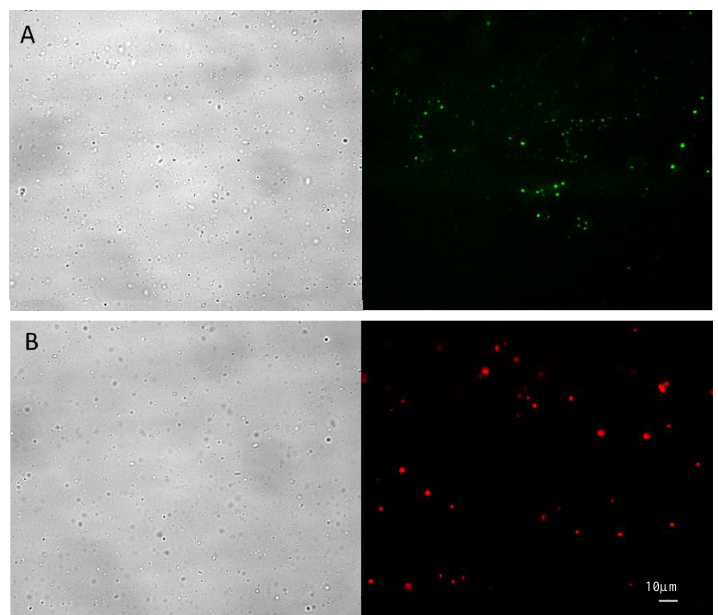
Figure 3. Optical ( left ) and fluorescence ( right ) microscopy images of: ( A ) unlabeled NHs; and ( B ) rhodamine-marked NHs (NHs-rho). Interval is 10 µ m